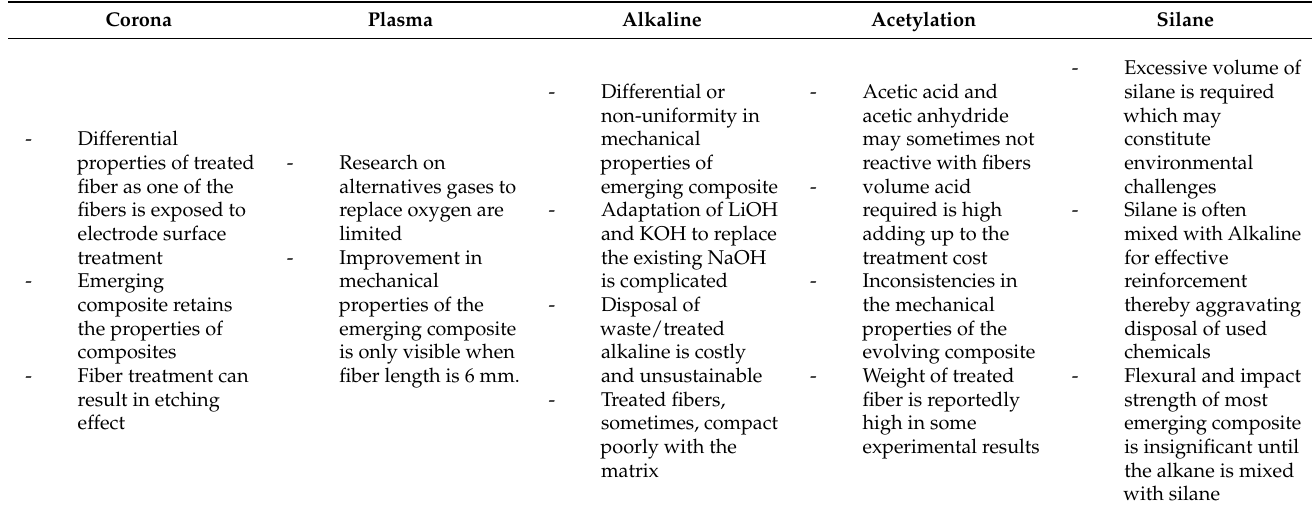
Table 13. Summary of limitations for several physical and chemical